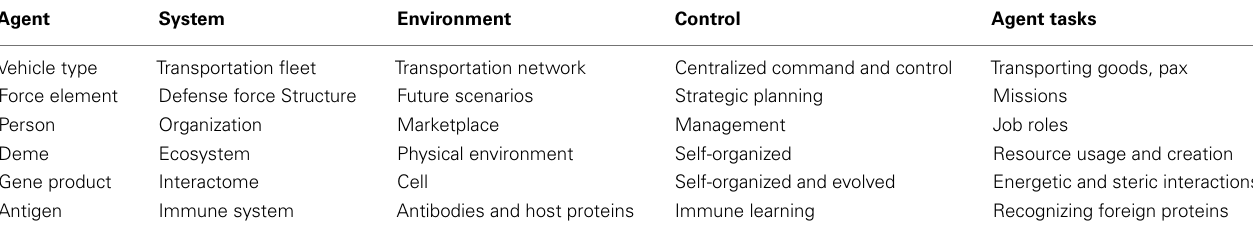
Table 3 | System classes where components (agents) are multi-functional and have functions that can partially overlap with other